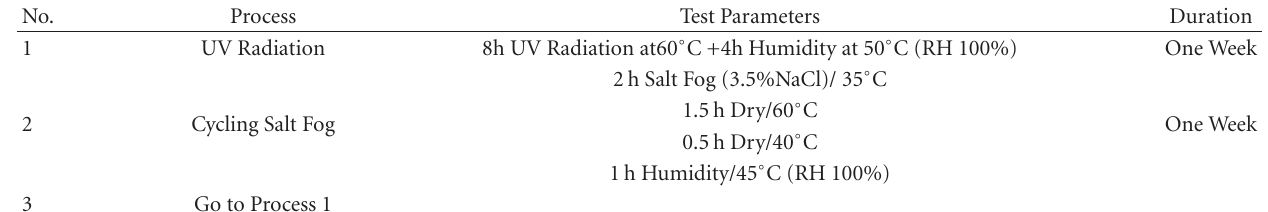
Table 2: Method of accelerated degradation test.